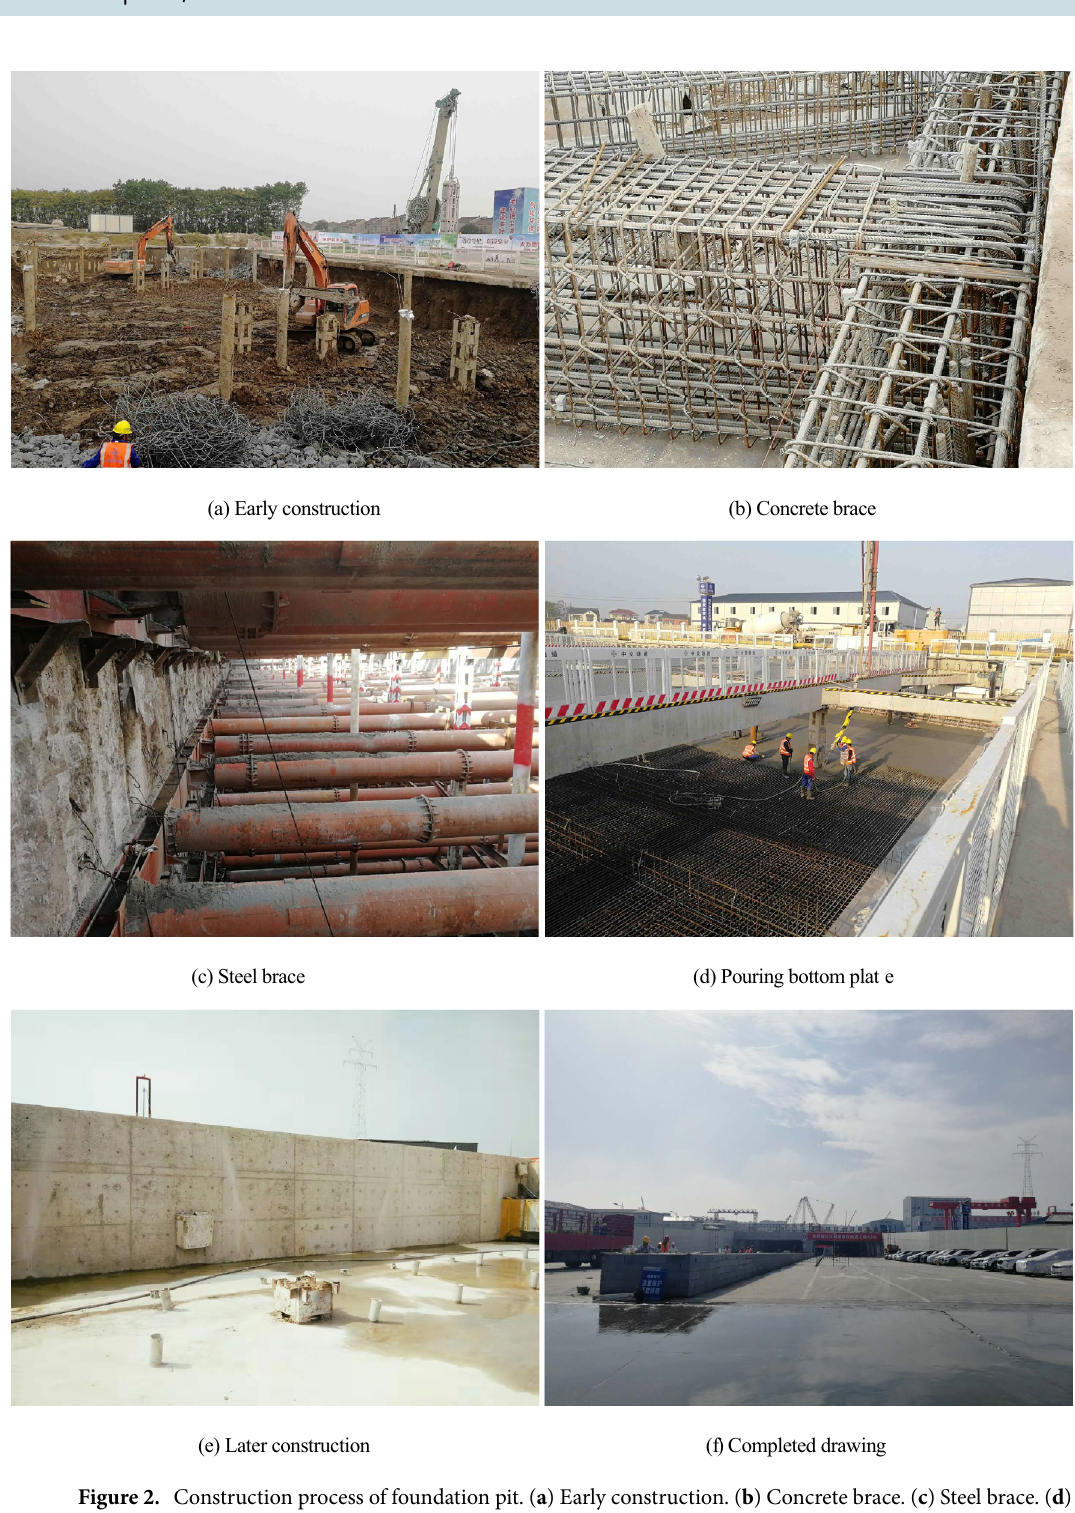
Figure 2. Construction process of foundation pit. ( a ) Early construction. ( b ) Concrete brace. ( c ) Steel brace. ( d ) Pouring bottom plate. ( e ) Later construction. ( f ) Completed